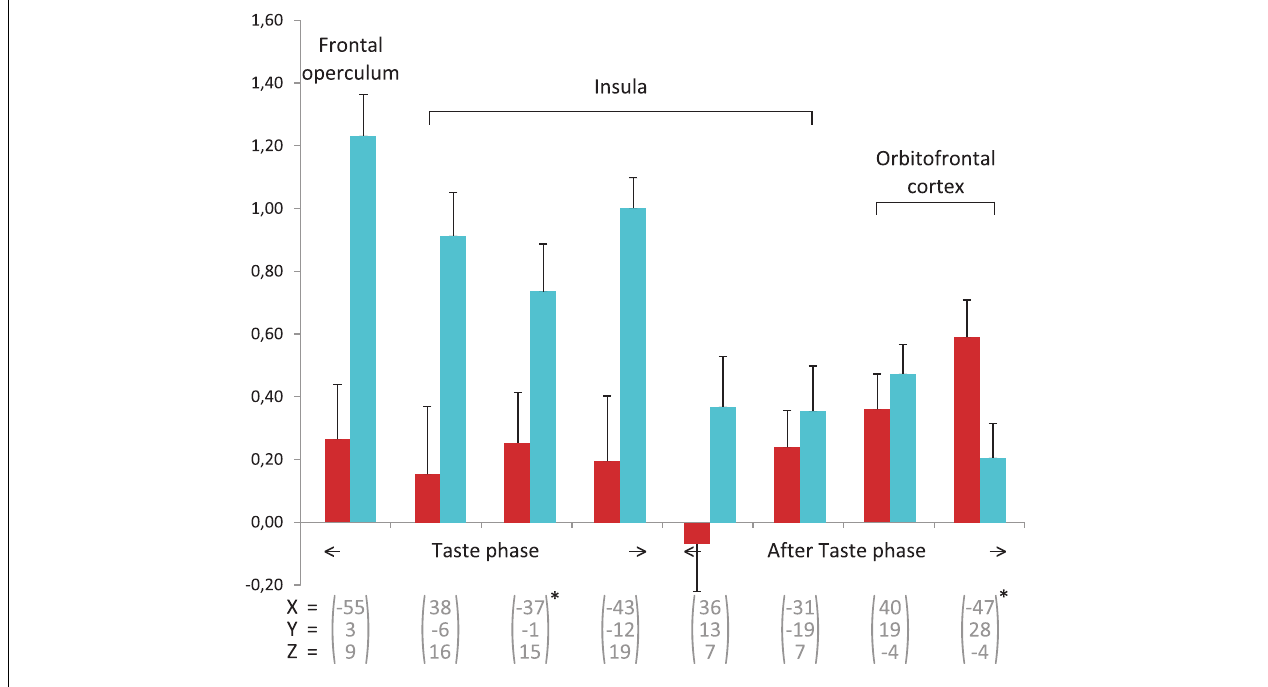
FIGURE 2 | Beta-value averages for the areas involved in flavor, based on Table 2. For each area from a group, the average values are given for the experts Group (red) and the Controls group (blue). The